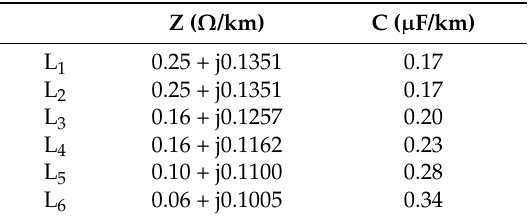
Table 1. Line parameters within the offshore wind farm